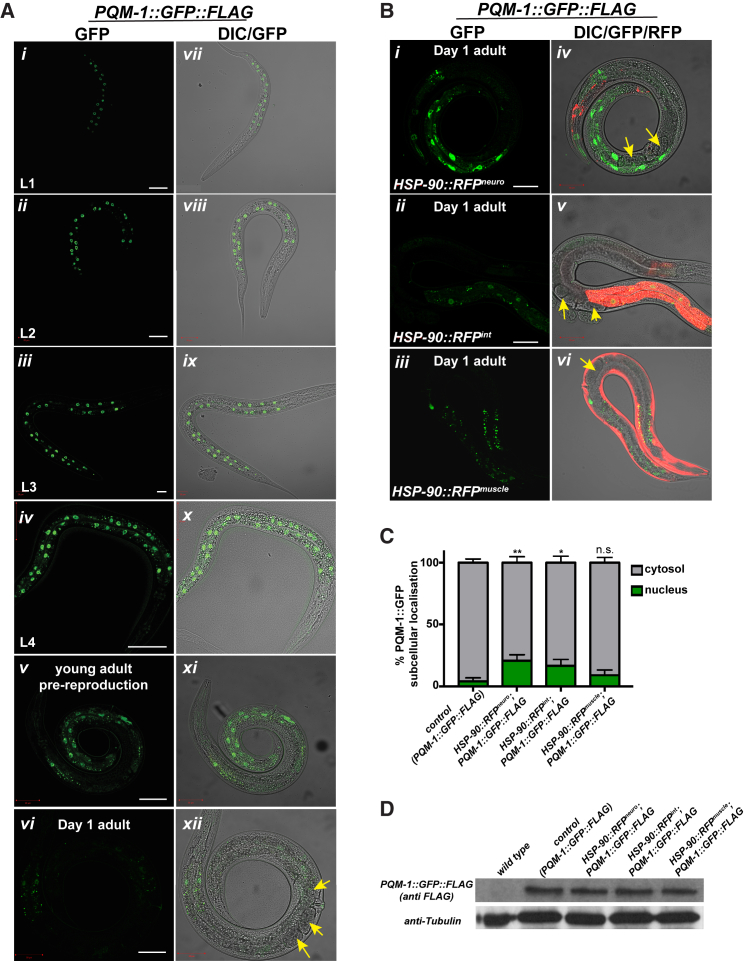
PQM-1::GFP::FLAG Remains Nuclearly Localized in the Intestine of Young Adult C. elegans Expressing HSP-90::RFPneuro or HSP-90::RFPint(A) Expression of PQM-1::GFP::FLAG (strain OP201) during larval stages L1(i and vii), L2 (ii and viii), L3 (iii and ix), and L4 (iv and x). PQM-1::GFP nuclear localization becomes diffuse in early pre-reproductive adults (56 hr after hatching at 20°C) (v and xi) and disappears in day 1 adults (65 hr after hatching) (vi and xii). Scale bar, 20 μm (i–iii). Scale bar, 50 μm (iv-vi). Yellow arrows denote eggs present in the day 1 adult.(B) PQM-1::GFP::FLAG localizes to intestinal nuclei in TCS-activated strains HSP-90::RFPneuro (i and iv), HSP-90::RFPint (ii and v), and HSP-90::RFPmuscle (iii and vi). Scale bar, 50 μm. Yellow arrows indicate eggs.(C) PQM-1::GFP::FLAG in HSP-90::RFPneuro, HSP-90::RFPint, or HSP-90::RFPmuscle was scored for nuclear and cytosolic localization and compared to the control strain (n > 20 per strain). ∗p < 0.05; ∗∗p < 0.01; Kruskal-Wallis test. Error bars represent ± SEM.(D) Western blot analysis of PQM-1::GFP::FLAG in TCS-activated strains compared to control animals using an anti-FLAG antibody. Tubulin was used as a loading control.